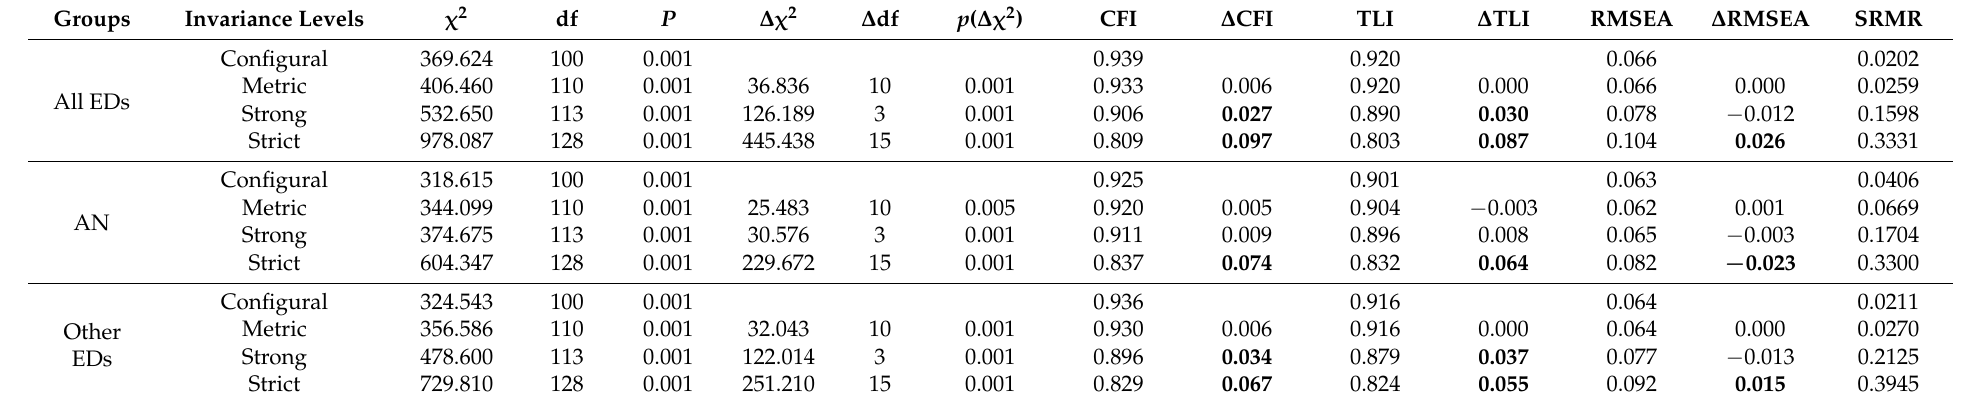
Table 7. Invariance of 12-item IAT across female groups (women with EDs vs. healthy university student).